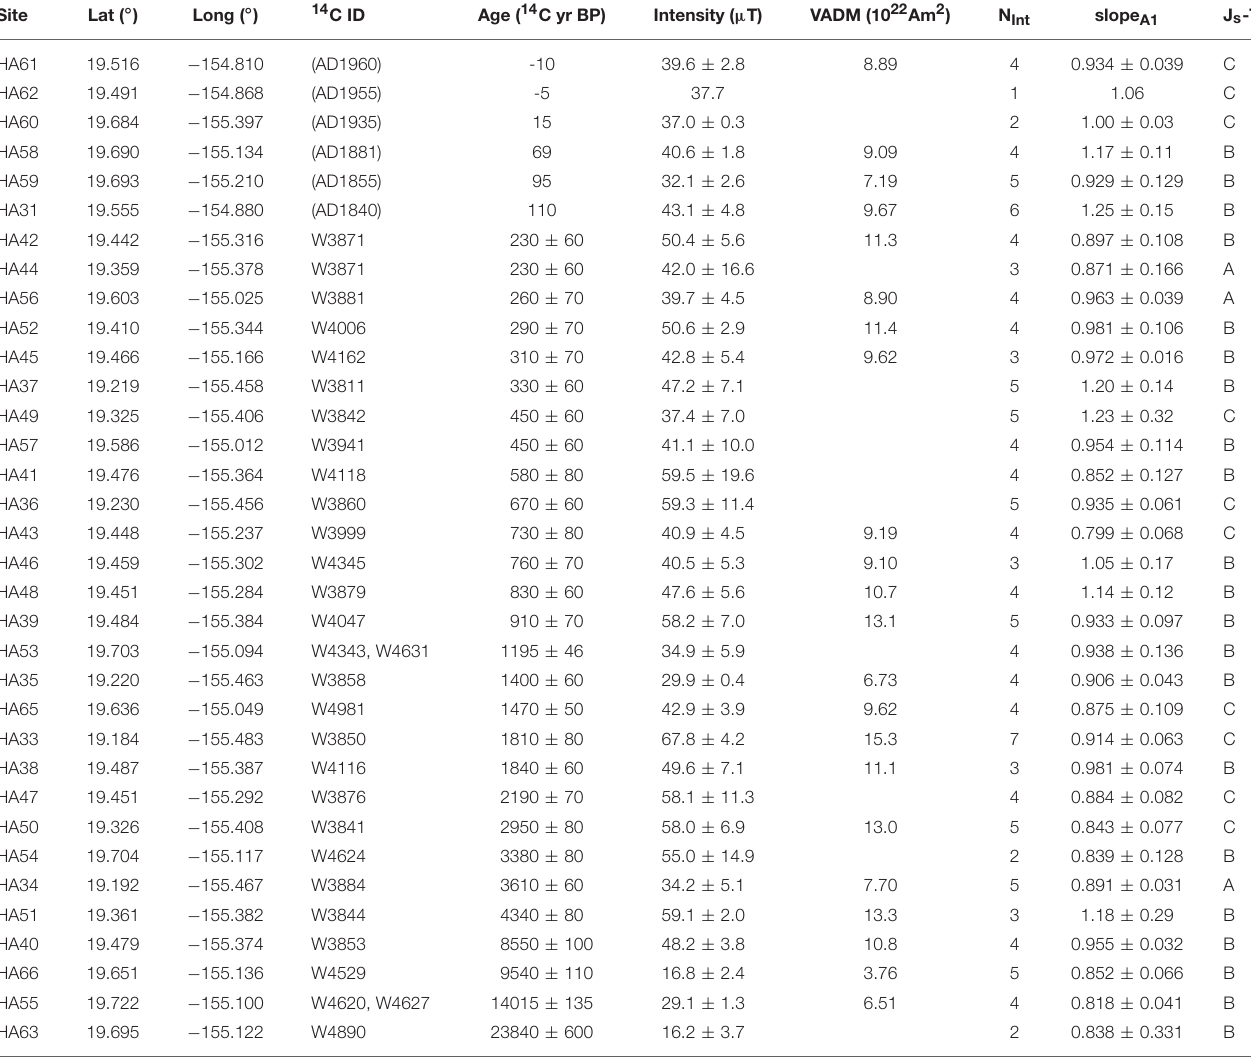
TABLE 1 | Statistical results for Tsunakawa–Shaw